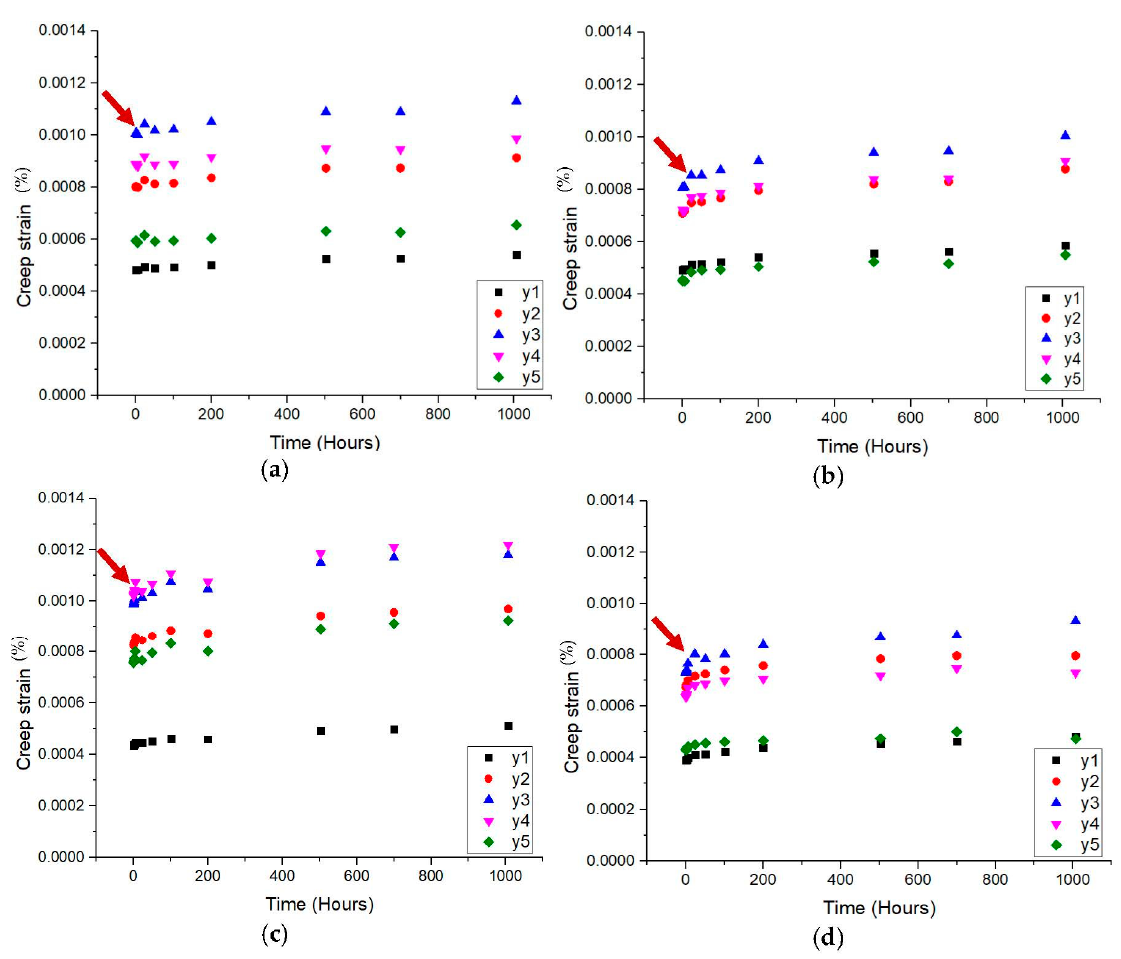
Figure 9. Creep strain-time curves for current wooden timber cross-arm for ( a ) left and ( c ) right; braced wooden timber cross-arm for left ( b ) and right ( d ) main member.